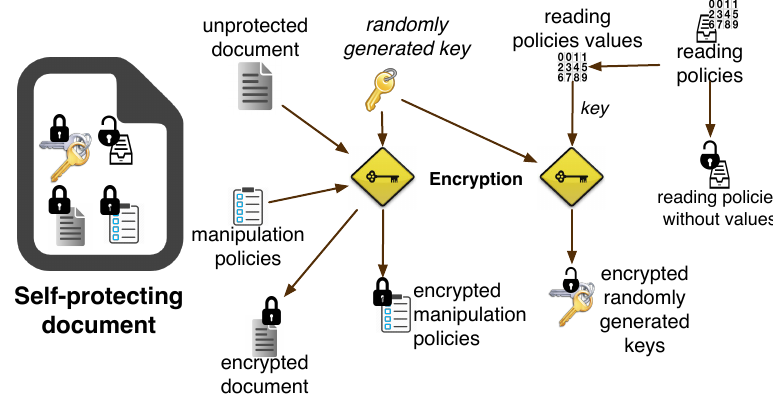
Figure 4. Structure and creation of a SmartContent